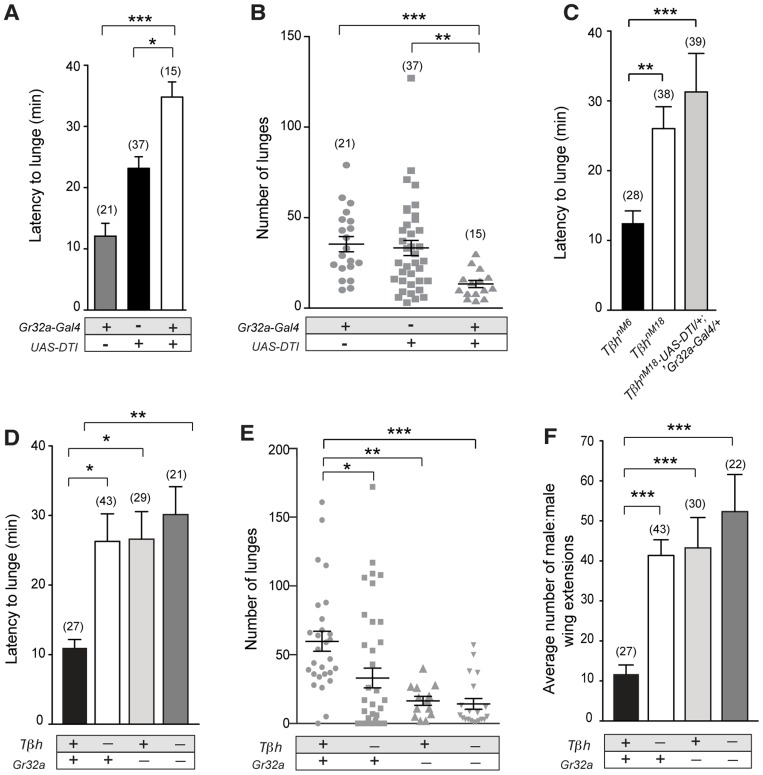
Gr32a-expressing neurons promote aggression via OA signaling.(A–B) Fights between males with Gr32a-expressing neurons removed by expressing Diptheria Toxin (UAS-DTI;Gr32a-Gal4) and individual transgenic controls, UAS-DTI or Gr32a-Gal4. (A) The latency to first lunge was significantly higher in UAS-DTI/+; Gr32a-Gal4/+ males as compared to controls (all statistical tests are Kruskal-Wallis with Dunn's multiple comparison test except where noted, ***p<0.001, *p<0.05). (B) Number of lunges (represented by each dot) performed in a 30 min period after the first lunge by any control or experimental male in a fighting pair. Males without Gr32a neurons exhibited a significant reduction in lunges as compared to controls (***p<0.001, **p<0.01). (C) Fights between control male pairs (revertant tβhM6 allele), experimental males without OA (revertant null mutation, tβhnM18), or experimental males without OA and without Gr32a-expressing neurons (tβhnM18;UAS-DTI/+; Gr32a-Gal4/+). The latency to first lunge was significantly higher in males without OA and in experimental males compared to control males (**p<0.01) and not statistically different between males without OA and experimental tβhnM18;UAS-DTI/+; Gr32a-Gal4/+ males. (D–F) Fights between control male pairs (revertant tβhM6 allele) and three groups of experimental males; without OA = tβhnM18, without Gr32a receptors = tβhM6;;Gr32a−/−, and without OA and Gr32a receptors = tβhnM18;;Gr32a−/−). (D) The latency to first lunge was significantly higher in males without OA (tβhnM18) and in experimental males without OA and the Gr32a receptor (tβhnM18; Gr32a−/−) or without only the Gr32 receptor (tβhM6; Gr32a−/−) males as compared to control tβhM6 males (One way ANOVA, post hoc Tukey's comparison, *p<0.05, **p<0.01). (E) The number of lunges by pairs of experimental males were significantly less than exhibited by control males but not when compared to each other (***p = 0.0002, **p = 0.002, *p = 0.01). (F) The average number of wing extensions directed toward the second male in each aggression assay. The number of wing extensions exhibited by males without the Gr32a receptor and without OA, and males without Gr32a receptors were significantly greater than control tβhM6 males (***p<0.001) but not males without OA (tβhnM18). Error bars denote s.e.m.